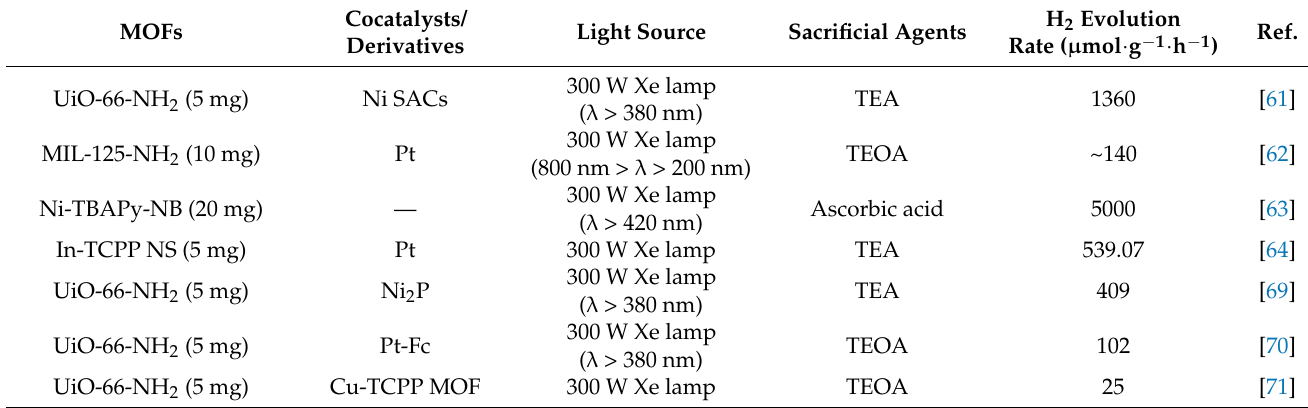
Table 1. The comparison of the H 2 evolution rates in the articles mentioned in this review.